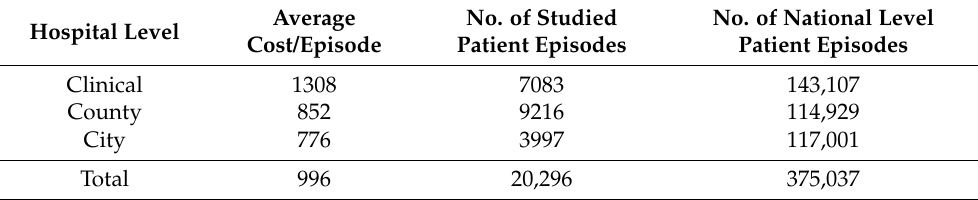
Table 2. Average cost (EUR) of CHF patient episodes stratified by hospital